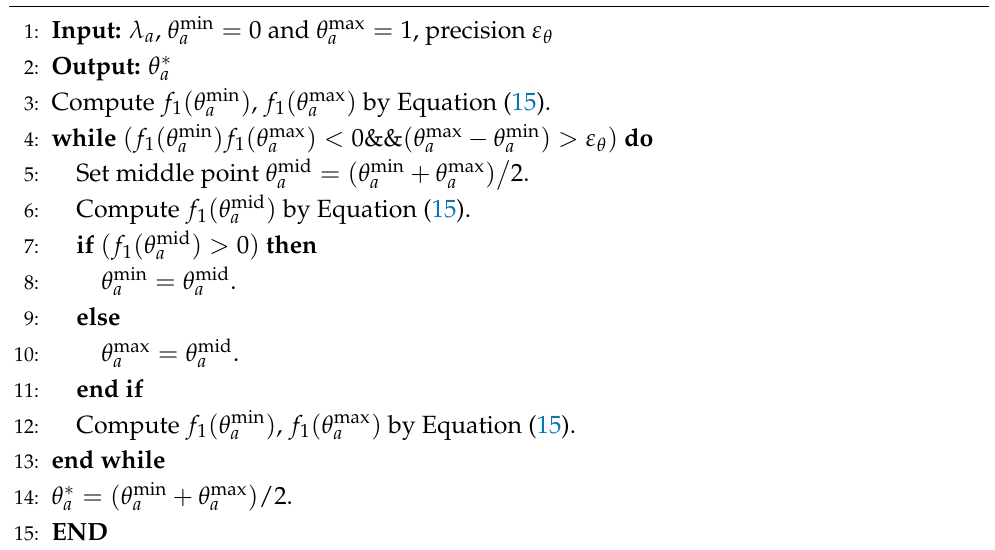
Algorithm 1 Find optimal θ ∗